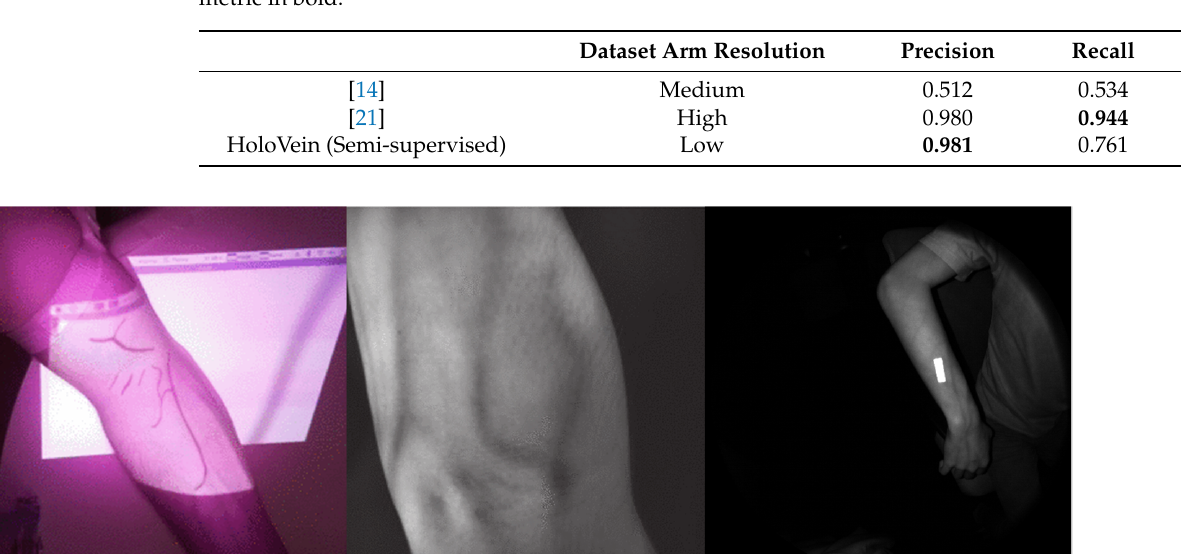
Figure 11. Comparison of model trained via 3D ‐ to ‐ 2D iterative projections against baseline model: ( Left ) Changes in metrics after 5 super ‐ epochs compared to the baseline model; ( Right ) Changes in performance across super ‐ epochs. Table 3. Performance comparison across existing U-Net solutions, with highest score per evaluation metric in bold.